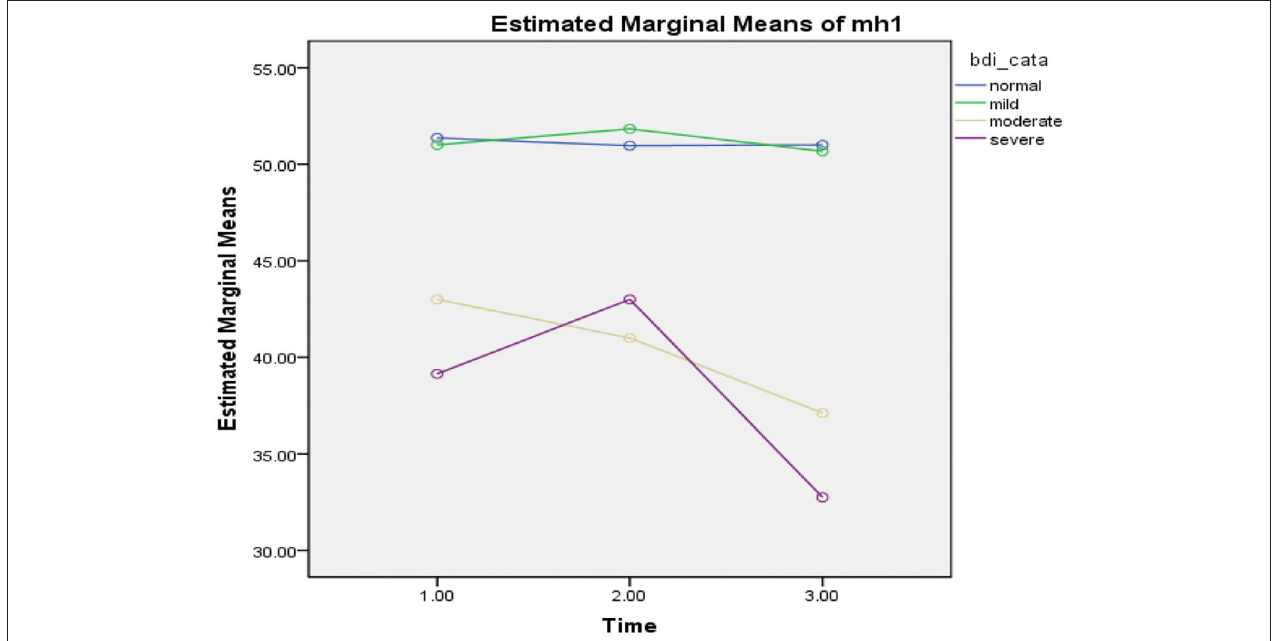
FIGURE 6 | Mean difference of mental health between T-0 (pretesting phase), T-1 (posttesting phase), and T-2 (follow-up phase) with different levels of depression in Pakistan students during COVID-19 epidemic lockdown ( N = 40). Time, three phases; bdi_cata, severity level of depression; quality of life total, quality of life.